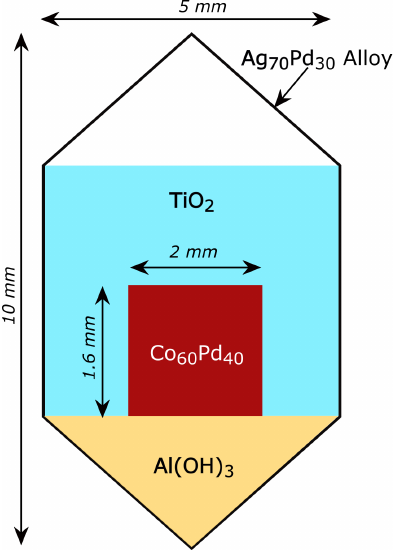
Figure 1. Configuration of the redox sensor capsules. The capsules are approximately 10mm long and are made of Ag 70 Pd 30 alloy or Pt. First, Al ( OH ) 3 was loaded into the capsule, and then a pressed metal powder pellet containing 60wt% Co and 40wt% Pd was placed in the center. The rest of the capsule was packed with TiO 2 to avoid physical contact between the CoPd pellet and the capsule